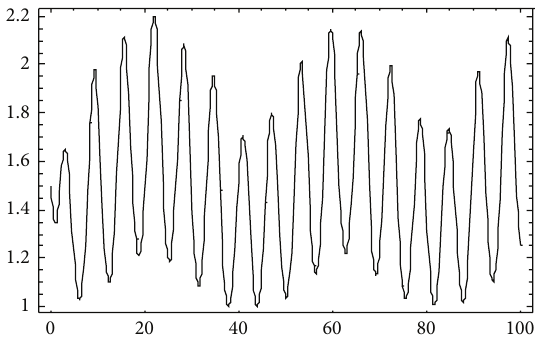
Figure 4: Time series analysis of slave system.